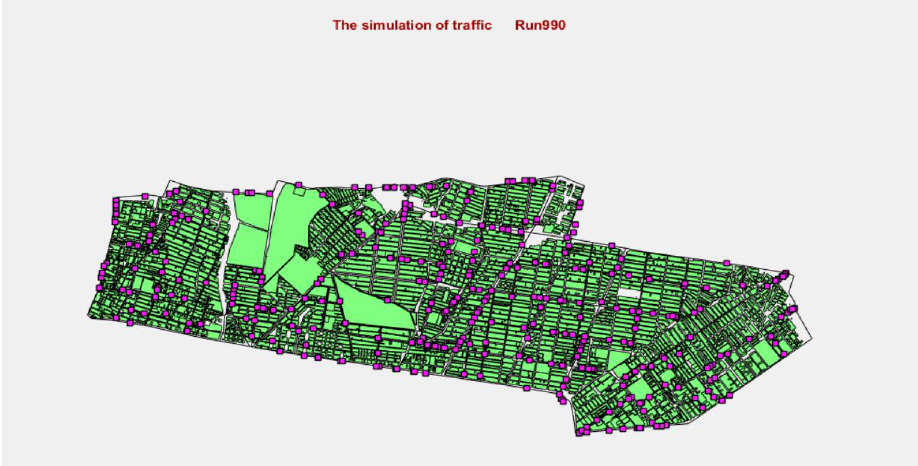
Fig. 7. Motion Detection of the GIS Traffic Simulator at 17:30